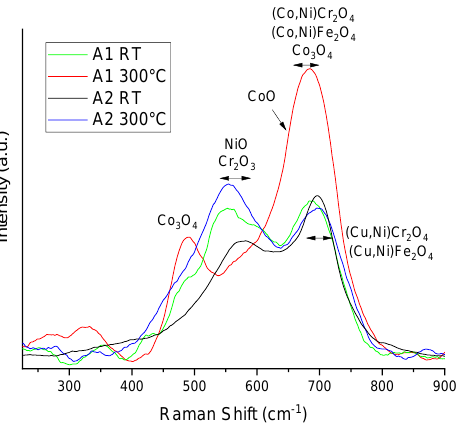
Figure 8. Raman spectra acquired inside A1 alloy and A2 alloy wear tracks after RT and 300 °C sliding.